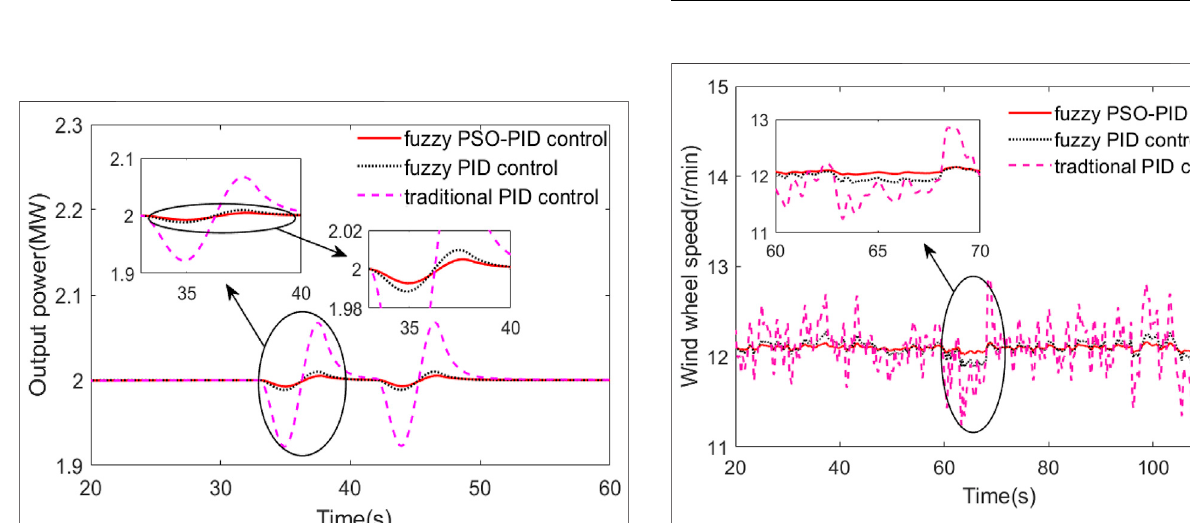
FIGURE 14 | Comparison curves of pitch angle under turbulent wind.